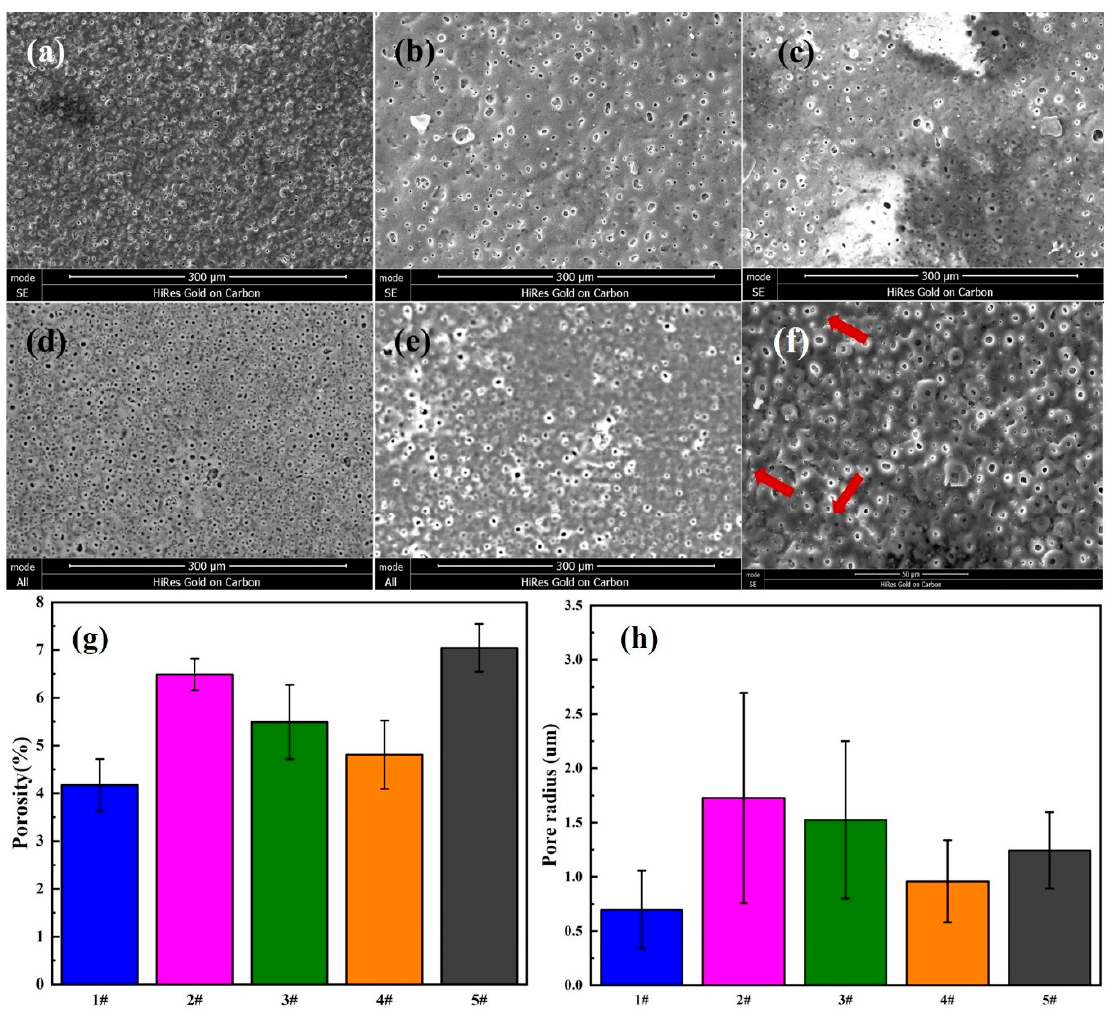
Figure 3. SEM images of the surface morphology ( a – e ), the high magnification ( f ), surface porosity ( g ) and pore size ( h ) of MAO-WE43 and GelMA / MAO-WE43 coatings. ( a ): 1#, MAO-WE43; ( b ): 2#, 1GelMA / MAO-WE43; ( c ): 3#, 5GelMA / MAO-WE43; ( d ): 4#, 10GelMA / MAO-WE43; ( e ): 5#, 15GelMA / MAO-WE43.